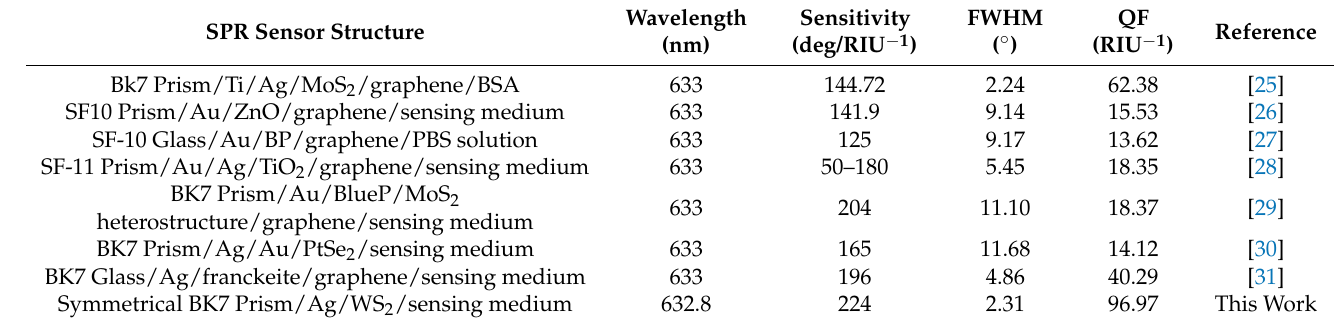
Table 4. Comparison of the structure and performance of the sensors designed in different studies.